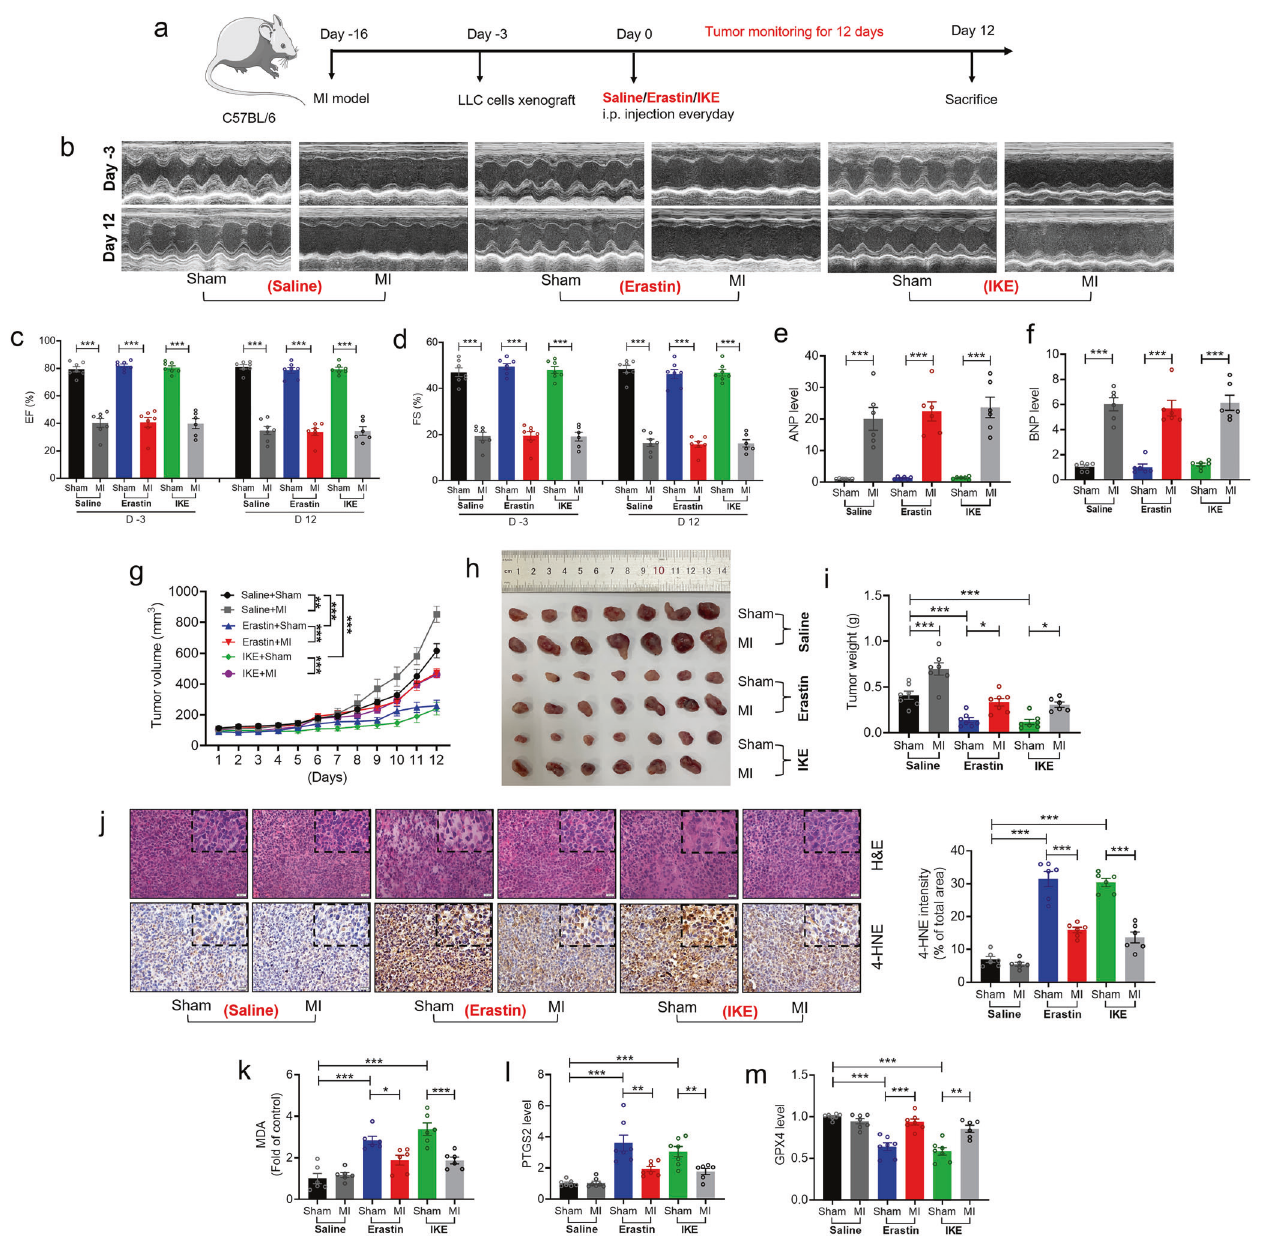
Fig. 1 MI reverses the inhibitory effect of erastin on tumor growth. a Schematic presentation on the time-line of in vivo cell transplantation; b – d Representative images of echocardiographs and statistical data on ejection fraction (EF%), fractional shortening (FS%) ( N = 6 – 7/group); e , f qRT-PCR analysis on the expression of ANP, BNP with heart tissues ( N = 6/group); g – i Representative images of tumors with corresponding ( g ) tumor volumes and ( i ) tumor weights in sham or MI C57BL/6 mice bearing LLC cells with erastin treatment ( N = 6 – 7/group); j Representative images of H&E and immunohistochemistry for 4-HNE staining and the higher magni fi cations of indicated area were shown at the top right corner. Quanti fi cation of 4-HNE intensity as % of total area (Bar: 20 μ m) ( N = 6/group); k The lipid formation was measured by MDA assay ( N = 6/group); l , m qRT-PCR analysis on the expression of PTGS2 and GPX4 from subcutaneous xenograft tissues in LLC tumor- bearing model ( N = 6/group). Data are expressed as mean ± SEM. * P < 0.05; ** P < 0.01; *** P < 0.001 were detected in both cell lines at 12 h (Fig. 3a), indicating that (Supplementary Fig. 4). These fi ndings indicate that exosomes exosomes can ef fi ciently fuse with tumor cells. Furthermore, derived from MI-induced HF can blunt the sensitivity of tumor to erastin increased lipid-ROS accumulation in LLC (5 μ M) and K7M2 ferroptosis. cells (20 μΜ ), and this effect, along with erastin-induced ferroptosis, was suppressed MI-EXO (1 μ g/mL) (Fig. 3b). As Effects of exosomes on erastin-induced ferroptosis in tumor cells expected, the MDA level was obviously increased by erastin, in vitro which was alleviated by MI-EXO (Fig. 3c). We then used a Sham-EXOs or MI-EXOs were isolated and co-cultured with mouse transmission electron microscope to observe the changes of the LLC lung carcinoma cell line or K7M2 osteosarcoma cell line. The ultra-microstructure in tumor cells. As shown in Fig. 3d, the exosomes labeled by Dil (DiIC18(3), a lipophilic membrane dye)